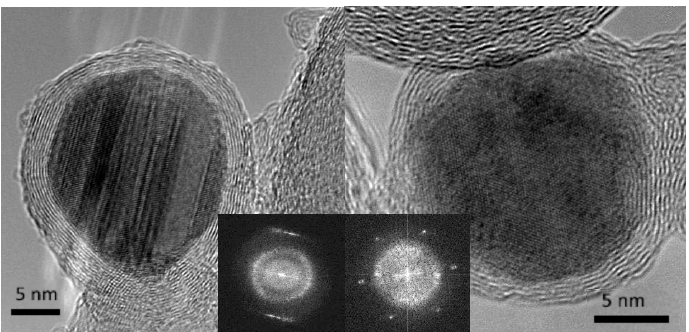
Figure 10. HRTEM images of typical encapsulated nanoparticles, with (inset) the central portions of their respective Fourier transforms to indicate the good crystallinity of both core (sharp spots/streaks in the Fourier transform) and the well-defined ring that arises from the carbon shell. Reprinted from [39] © IOP Publishing. Reproduced with permission. All rights reserved.